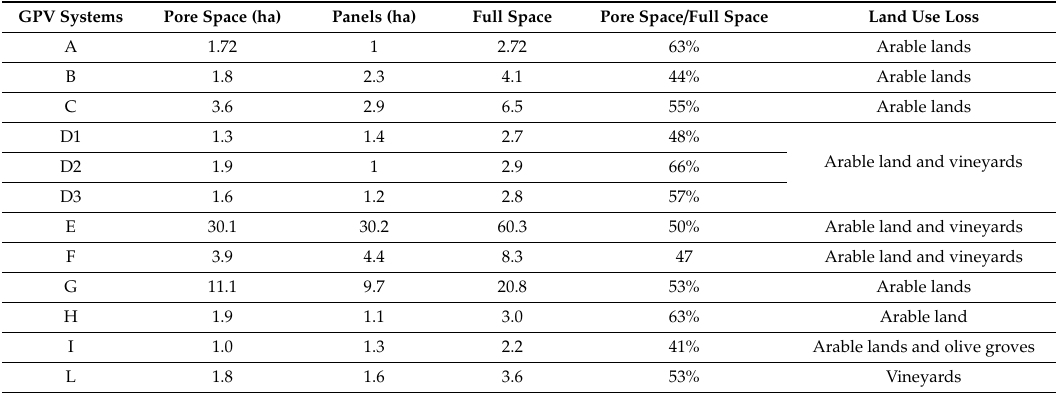
Table 2. The surface (ha) of the pore space and full space in GPV systems reported in Figure 4. GPV